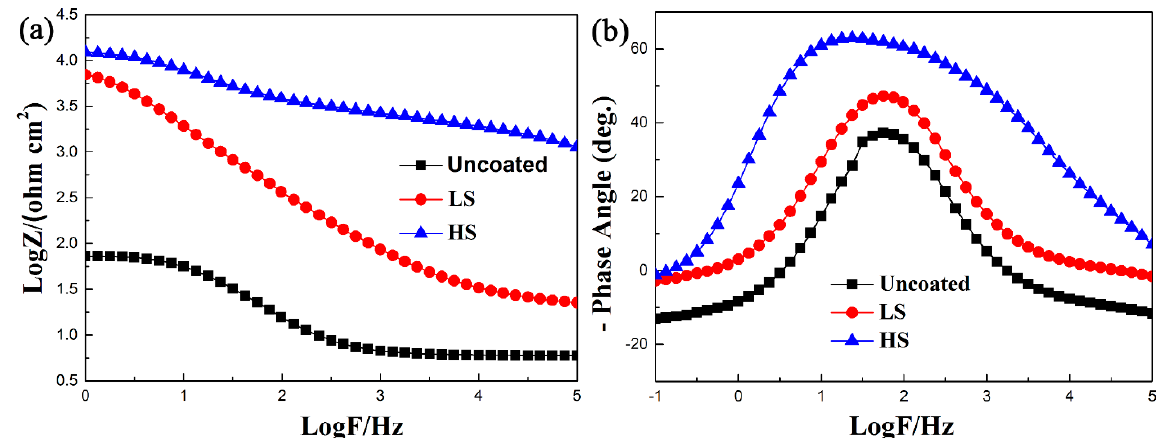
Figure 8. The bode ( a ) and phase angle ( b ) plots of the uncoated, LS and HS samples in the 0.5 M HCl solution at 30 °C.